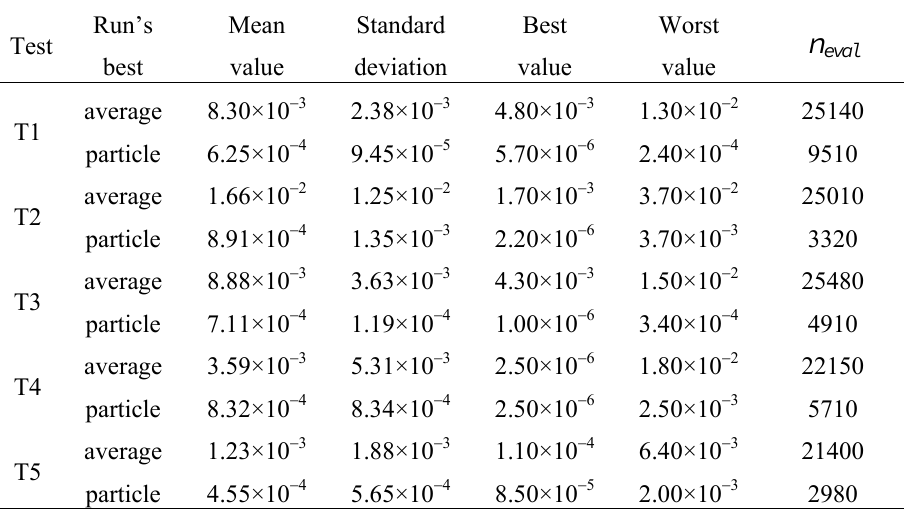
Table 6. Results of the tests T1 to T5 for example 3.